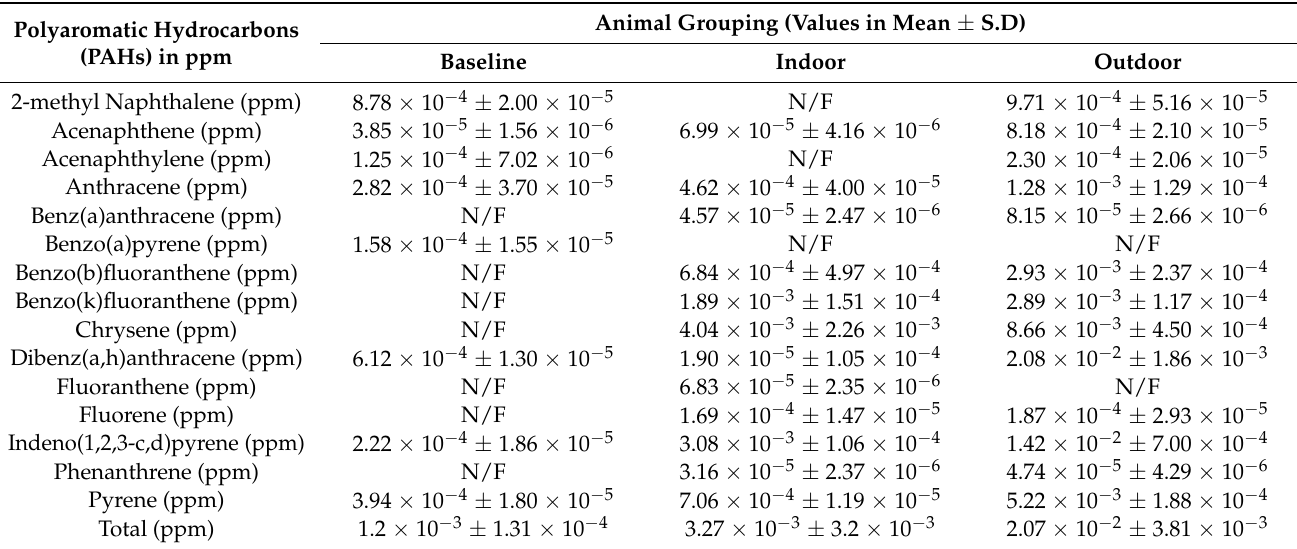
Animal Grouping (Values in Mean ±